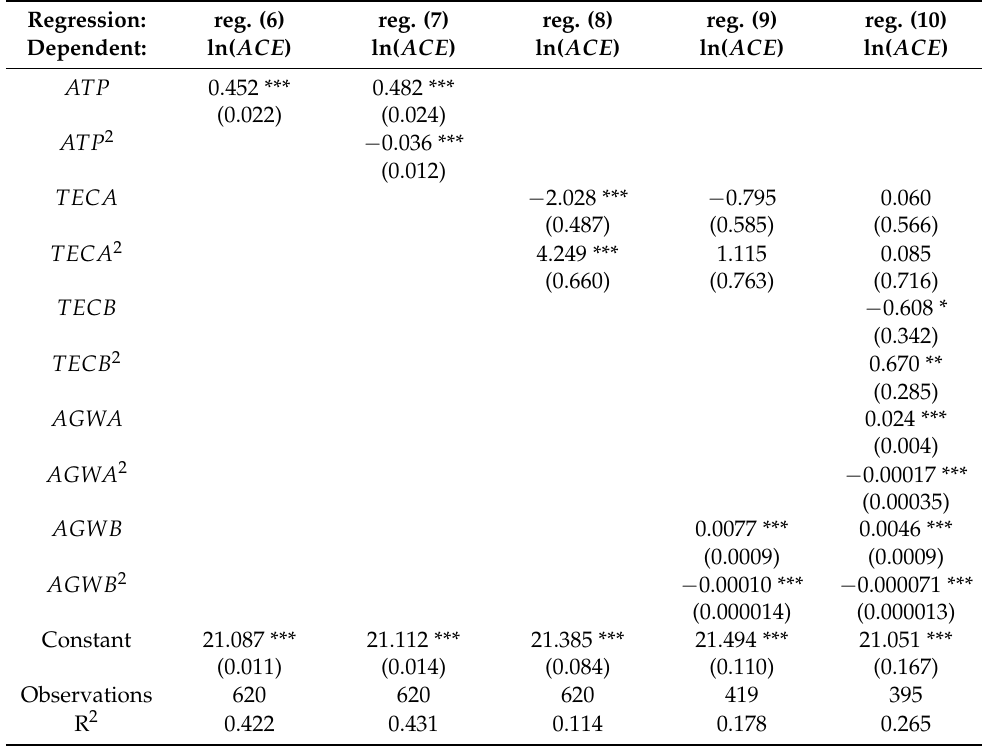
Table 5. Effects of agricultural technology progress on